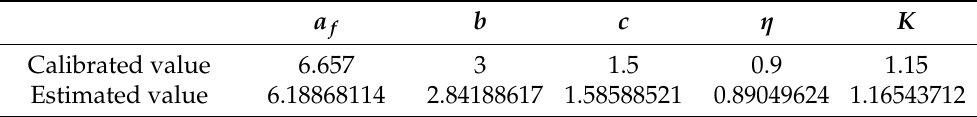
Table 5. Posterior estimation of the unknown parameters θ obtained from noisy synthetic